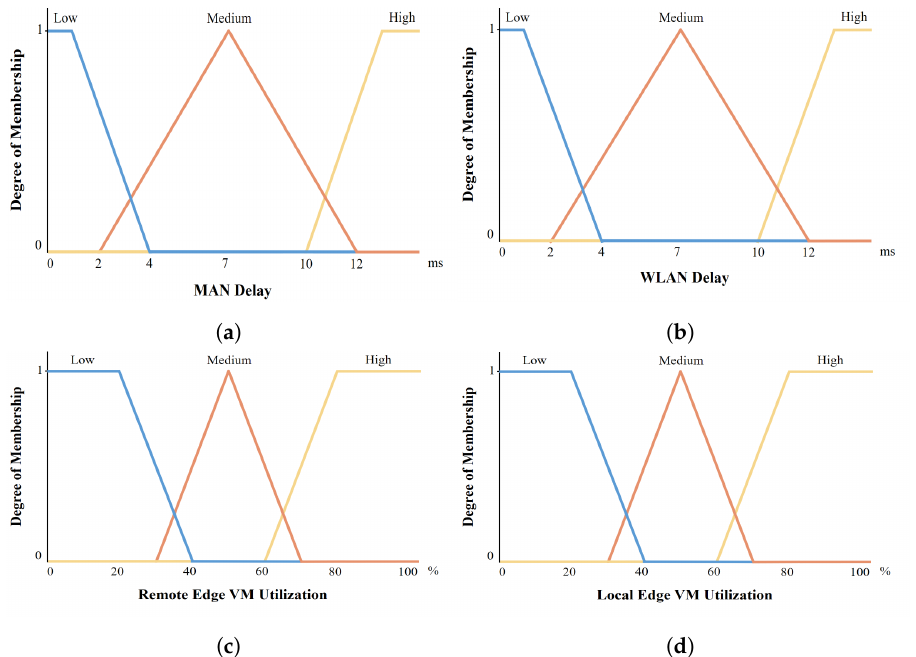
Figure 6. Set of membership functions for each input variable in the first FLS: ( a ) WLAN delay.